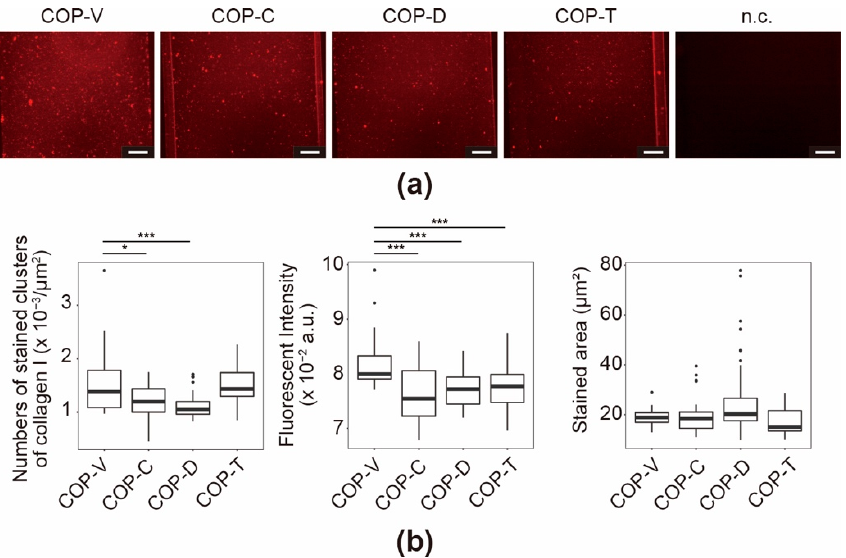
Figure 8. Immunofluorescence for collagen I (Col I) in Col I-coated cyclo-olefin polymer (COP) microfluidic channels. ( a ) Micrographs of immunostained Col I in Col I-coated COP microfluidic channels processed using vacuum ultraviolet (VUV)-photobonding (COP-V) or solvent-bonding with cyclohexane (COP-C), toluene (COP-T), or dichloromethane (COP-D). n.c. represents the negative control of a COP-V microfluidic channel coated with Col I and stained with a secondary antibody. Scale bars: 100 µm. ( b ) Quantitative analyses of immunostained Col I in the Col I-coated COP microfluidic channels. The center lines represent the medians; the box limits indicate the 25th and 75th percentiles; the whiskers extend to 1.5-times the interquartile range from the 25th and 75th percentiles; and outliers are represented by dots. Each experiment was repeated four times, and more than ten images of the COP devices from each experiment were used for quantification. * p < 0.05, *** p < 0.005.